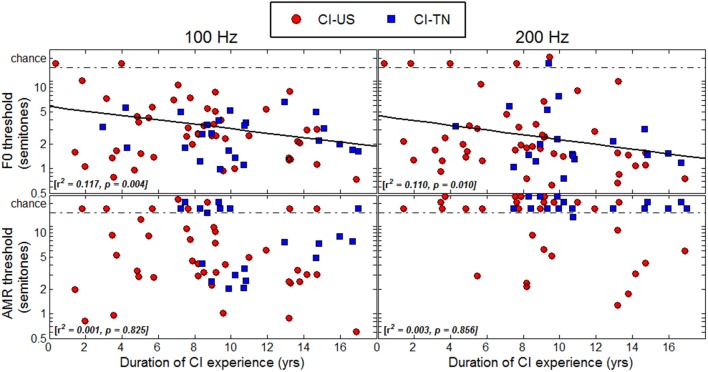
Thresholds as a function of duration of CI experience.